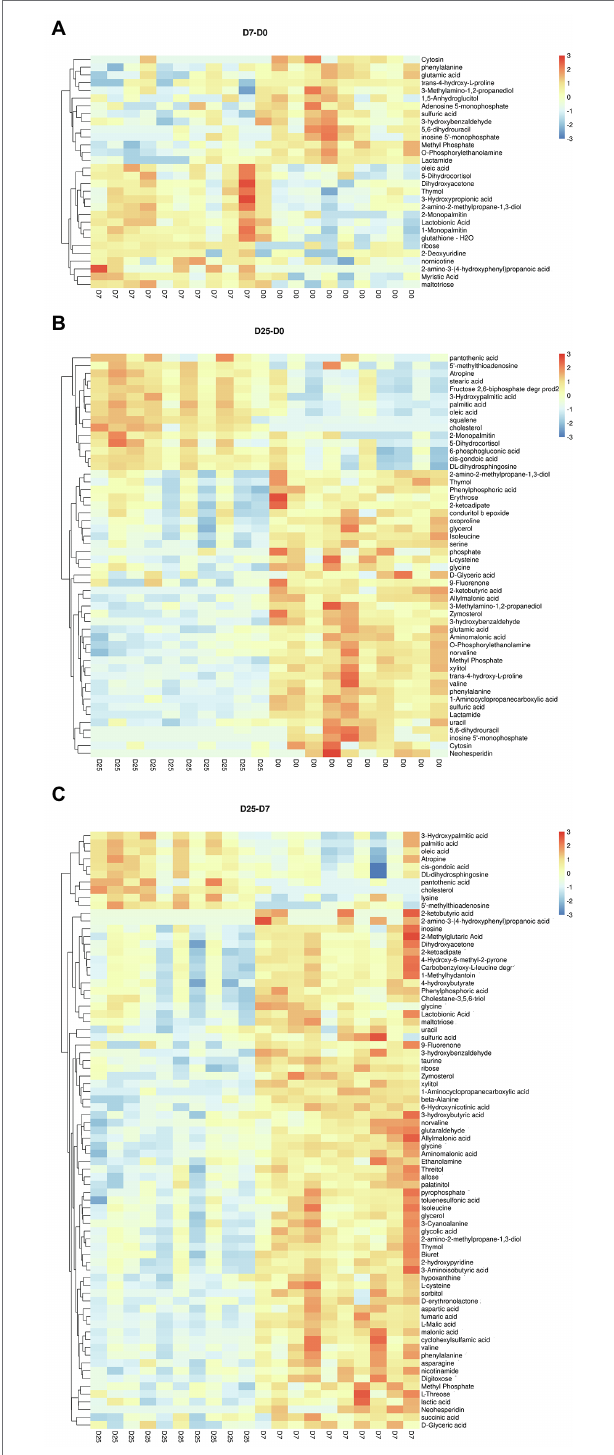
FIGURE 5 | Hierarchically clustered heat map for the significantly different metabolites. (A) Shows the D7 group compared to the D0 group. (B) Shows the D25 group compared to the D0 group. (C) Shows the D25 group compared to the D7 group. The up-regulated and down-regulated metabolites were indicated by different shade colors of red and blue, respectively. D0, overfeeding for 0 days; D7, overfeeding for 7 days; D25, overfeeding for 25